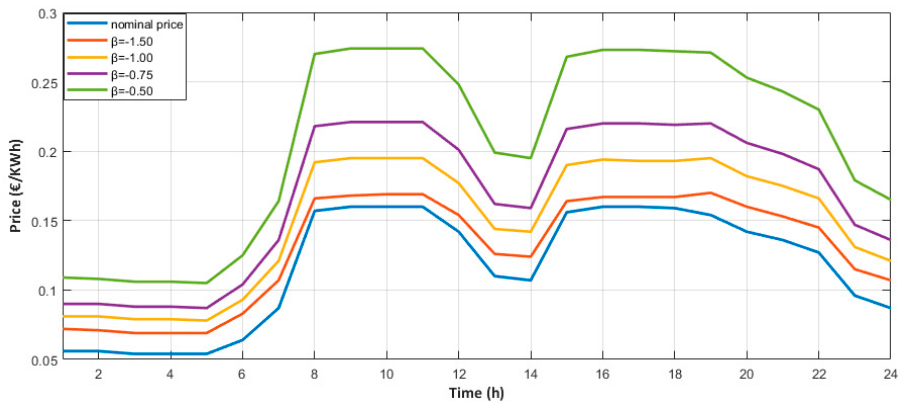
Figure 12. Nominal price and RTPs per elasticity values. (source: Authors).